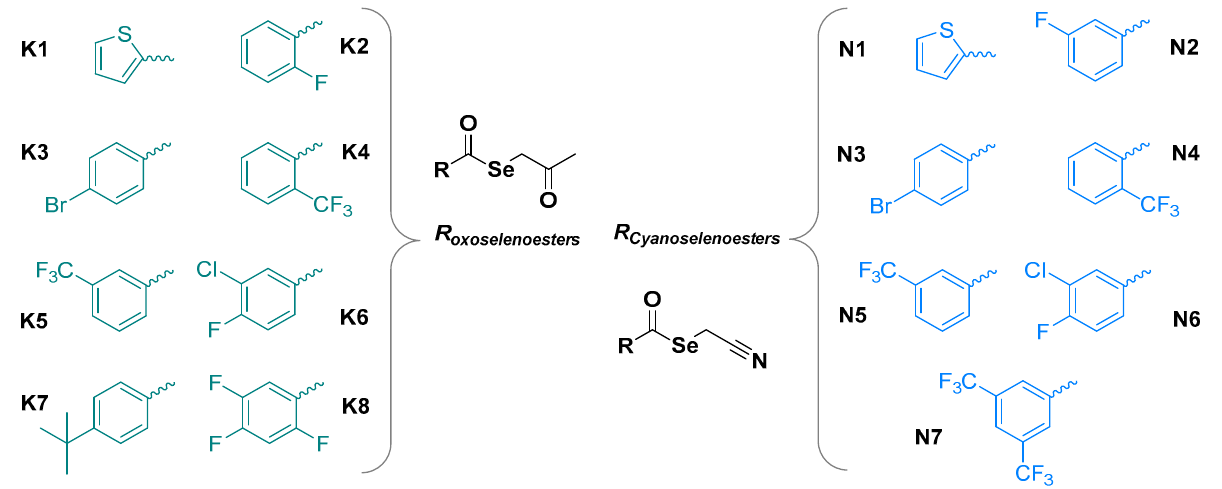
Figure 1. Structure of the oxoselenoesters, K1–K8, and of the cyanoselenoesters, N1–N7, presented in this work.